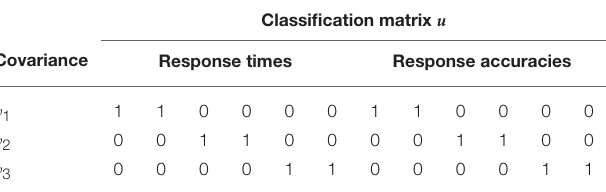
TABLE 3 | The additive covariance structure of the blocked structures of cross-covariances model is an extension of the BCSM for speed and ability with block-wise cross-covariances between RTs and RAs.